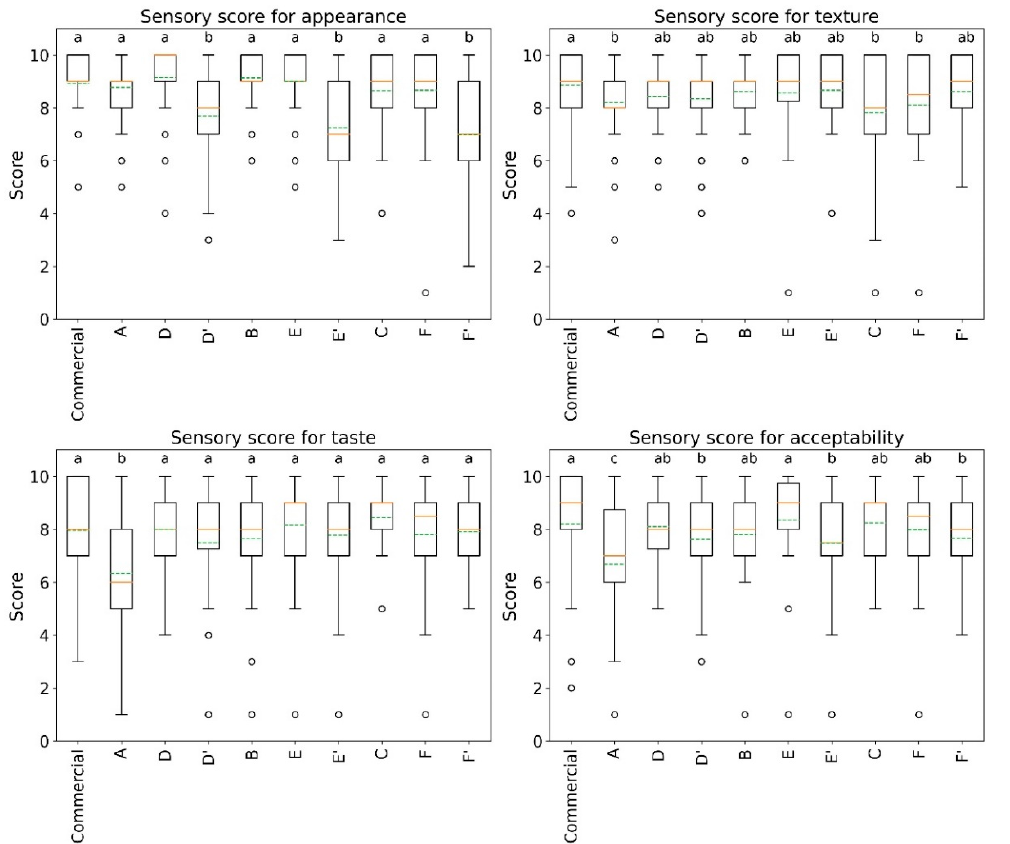
Figure 5. Structured scale results for sensory evaluation of low-fat mayonnaises. Dotted lines represent the arithmetic mean, and the solid yellow line indicates the median. Different letter in the same panel indicates a significant difference ( p < 0.05).